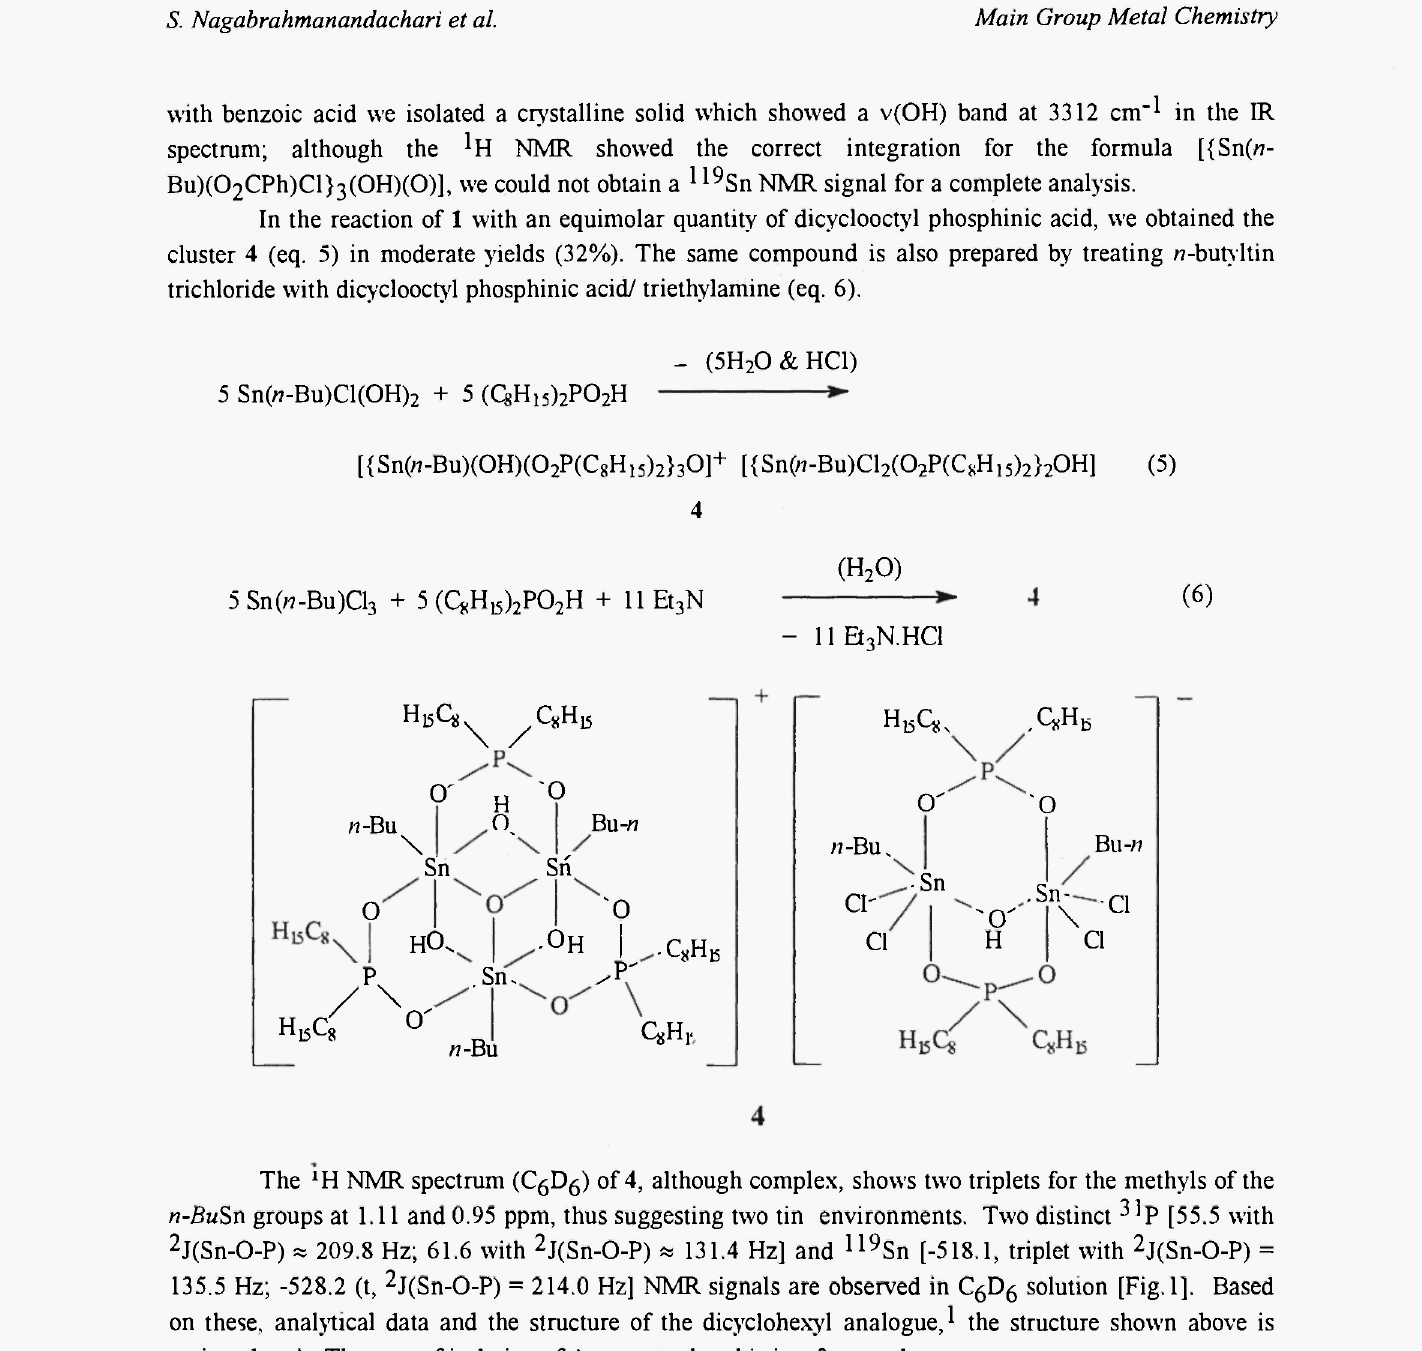
The 1:1 stoichiometric reaction of 1 with /-butylphosphonic acid led only to the known tetranuclear cage [{Sn(n-Bu)}2(0){0 2 (0H)P(/-Bu)} 4 ]2 (5) 4 in ca 18% yield (m.p., NMR and elemental analysis) (eq.